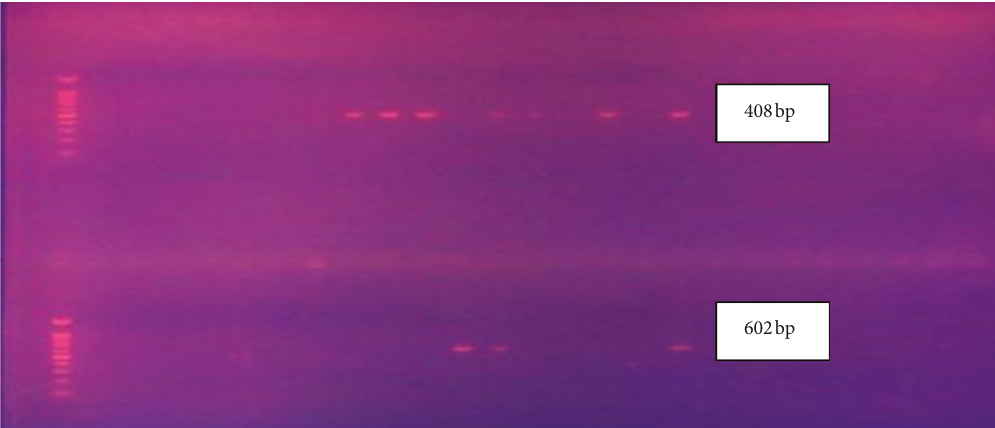
Figure 2: A representative gel image showing PCR products of qnrB (408bp) and qnrS (602